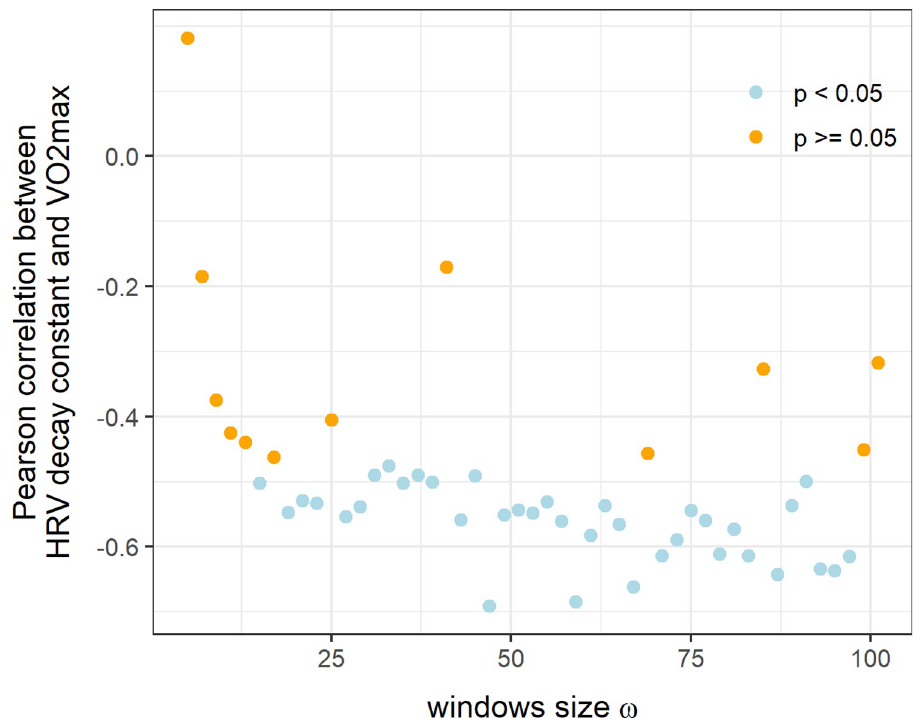
Fig 4. Results of the sensitivity analysis. Pearson correlation coefficient and associated p value (p < 0.05 or p > = 0.05) found between HRV decay constant and VO 2 max as a function of the windows size ω when using a 0 th (p = 0) order polynomial